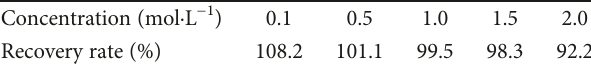
Table 2: Results of di ff erent concentrations of titrant.